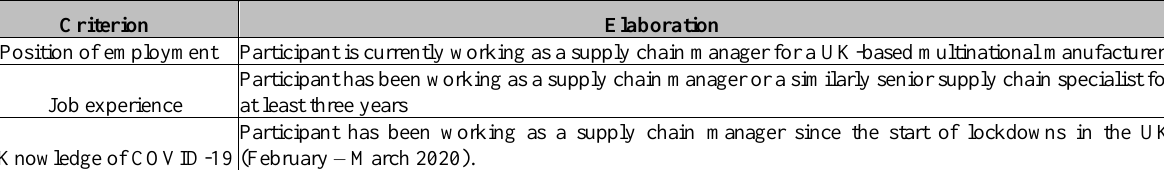
Table 1. Sample Inclusion